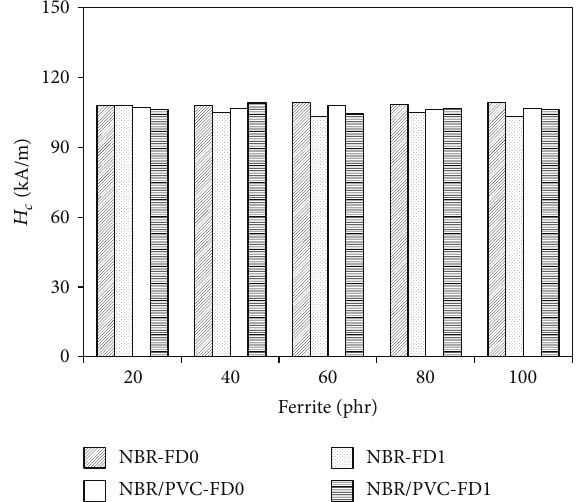
Figure 15: Influence of ferrites content on coercivity 𝐻 𝑐 of compos-